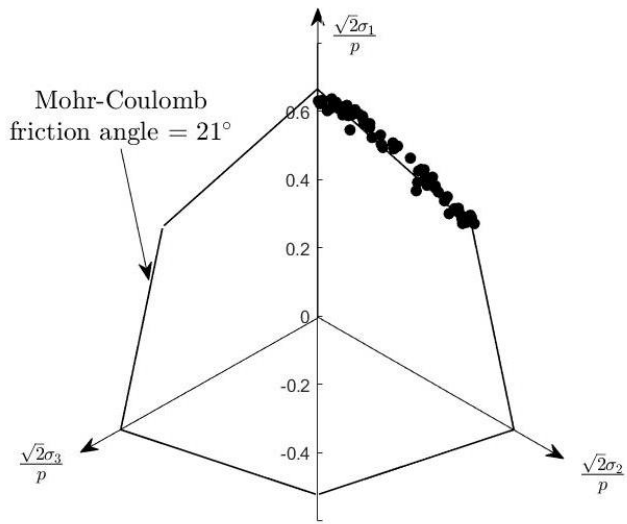
Figure 7. Stress state at the critical state.